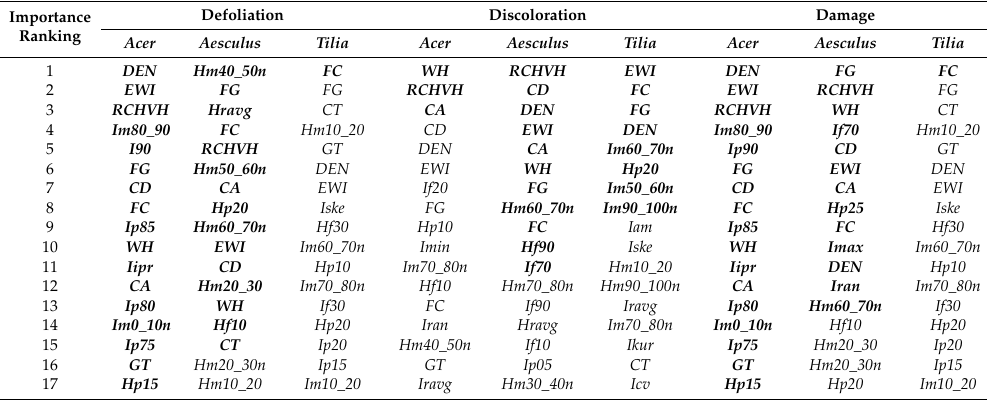
Figure A1. Distribution of tree health scores for the 131 sampled trees: ( a ) defoliation and discoloration scores; ( b ) defoliation and damage scores. Table A1. The 17 most important indices in ALS models (scenario 1) for tree crown defoliation, discoloration and damage (i.e., combination of defoliation and discoloration) classification. The indices used in the final classification models (according to the forward selection method; Section 2.6.3) are highlighted in bold. The explanation of the indices abbreviations can be found in Table 2.